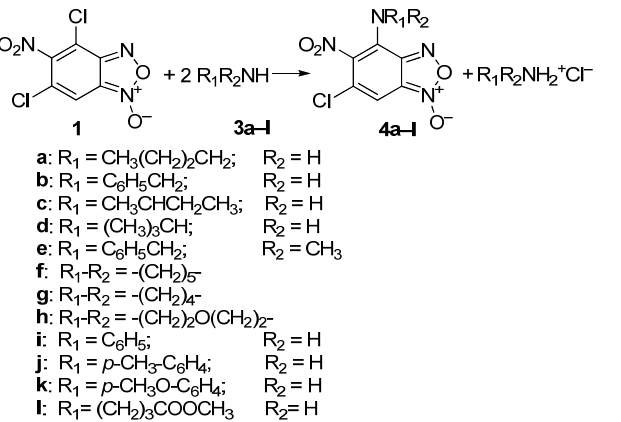
Scheme 1. Nucleophilic reactivity of 1 with amines.